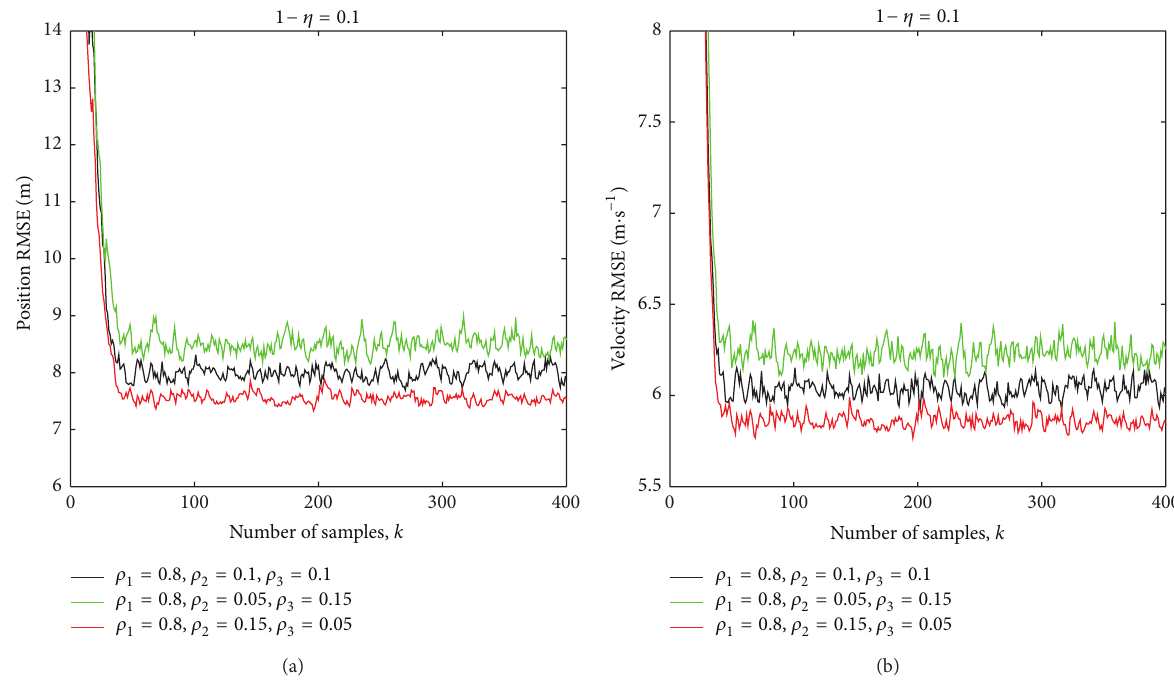
Figure 6: Comparison of the RMSEs for the proposed algorithm with different 𝜌 𝑞 (𝑞 = 1, 2, 3) : (a) position RMSE; (b) velocity